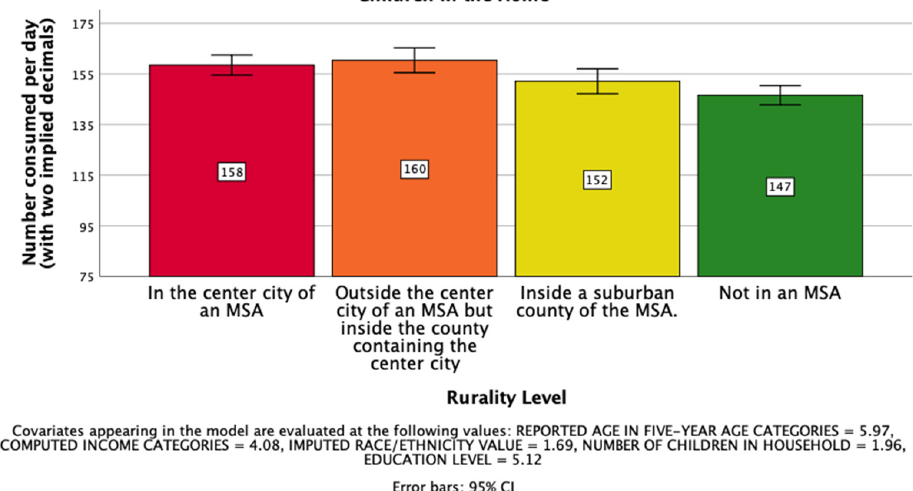
Figure 3. National Mean Overall Daily Fruit Intake.